Question: Give a one-sentence summary of this figure.
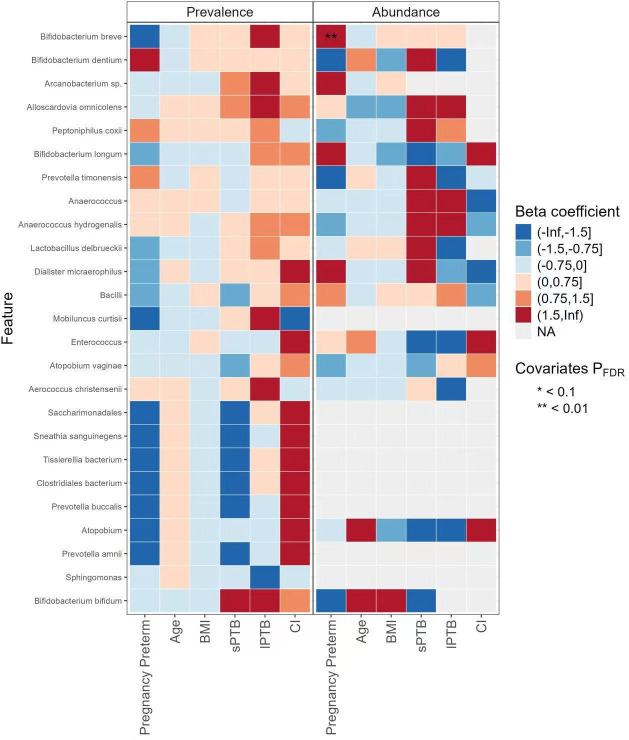
Answer: Differential abundance analysis. Heatmap showing taxa with nominally significant associations with sPTB in the second trimester (22–28 weeks) from MaAsLin3 analysis. The color scale indicates prevalence and abundance, with both set to 1.0 for all displayed taxa. Bifidobacterium breve is significantly overrepresented in the sPTB group, while no other taxa showed significant differences in the second trimester between the two groups after FDR correction; all the others had q values > 0.1 after multiple testing correction. *: P < 0.1. **: P < 0.01.